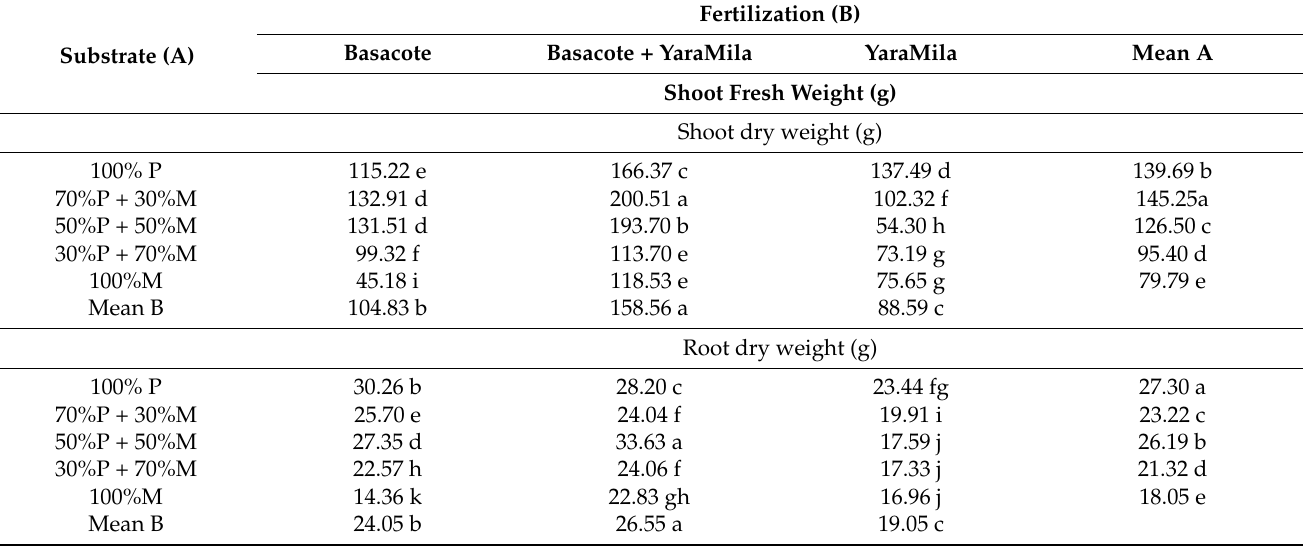
Table 6. Fresh and dry weight of Sedum spectabile ‘Stardust’ grown in containers with five different substrates.